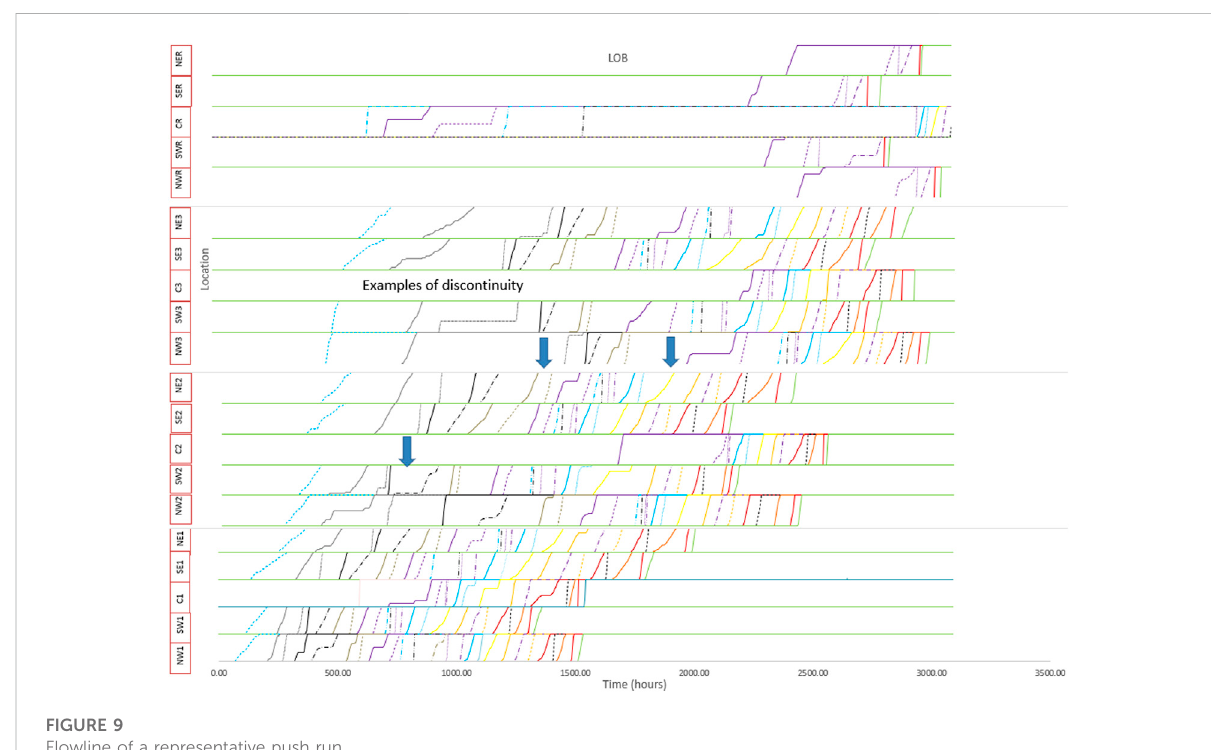
FIGURE 9 Flowline of a representative push